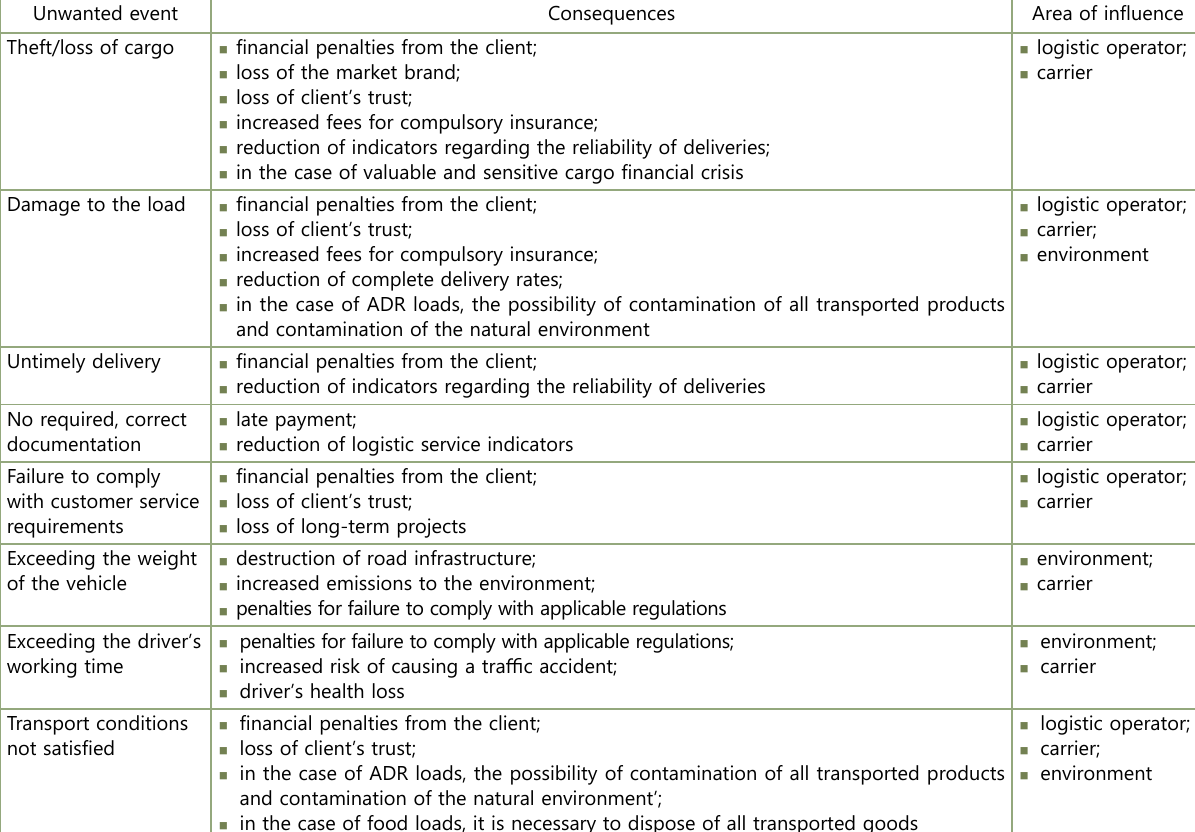
Table 1. Unwanted events with their consequences connected with applied system of carrier